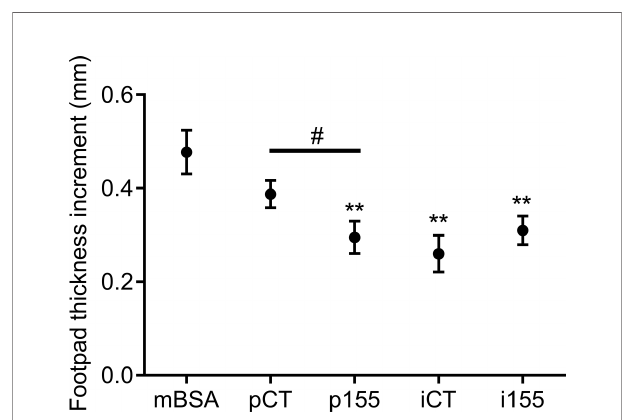
FIGURE 6 | Over-expression of mir-155 enhances the immunosuppressive function of MSCs in the DTH murine model. Mice were immunized by intradermal injection of methyl bovine serum albumin (mBSA) at day 0 and challenged by injection of mBSA ± MSCs transfected with pCT, p155, iCT or i155 in the footpad at day 5. Footpad thickness increment was determined after 24h. Statistical analysis used unpaired-t test with **p < 0.01 versus mBSA group and # p < 0.05 between indicated groups.